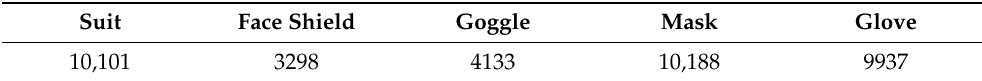
Figure 6. Categories of medical personal protective equipment. ( a ) Suit; ( b ) Face shield; ( c ) Goggle; ( d ) Mask; ( e ) Glove. Table 1. The number of different categories.